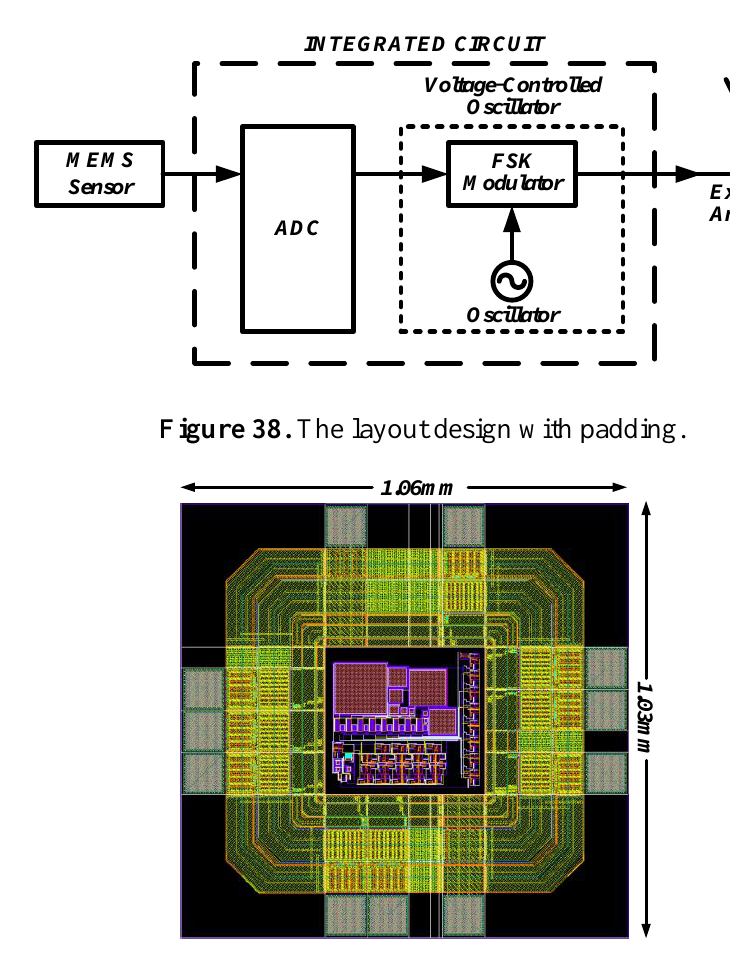
Figure 37. Block diagram of system design.